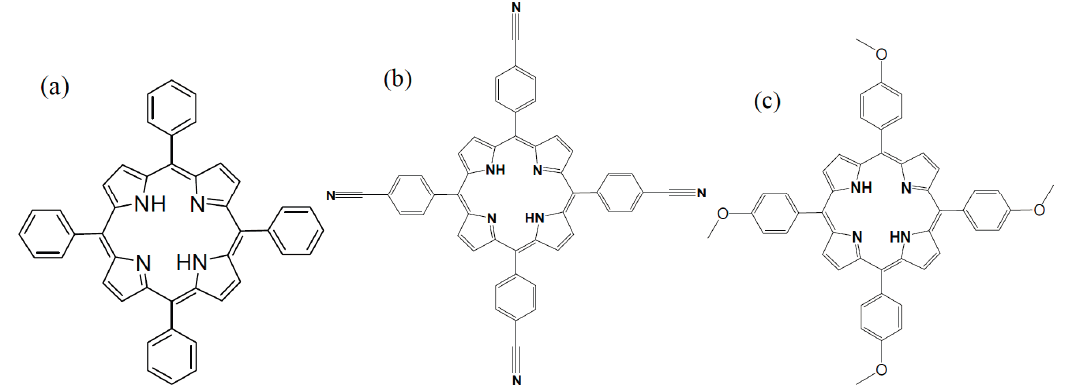
Figure 1. The molecular structures of ( a ) meso -tetraphenylporphyrin (TPP); ( b ) TPP(CN) 4 and ( c ) TPP(OMe) 4 .